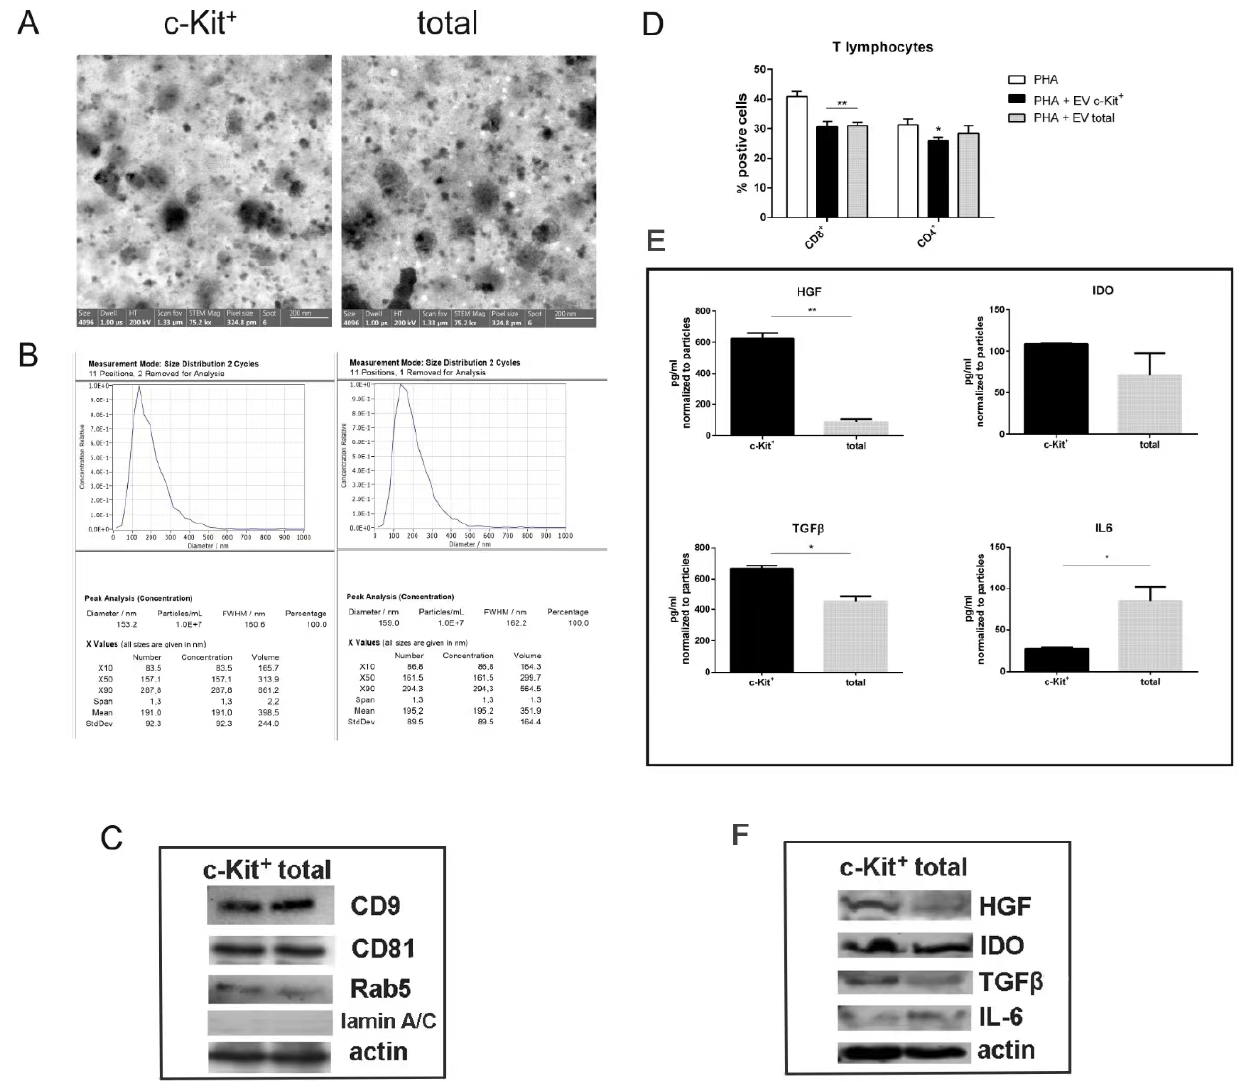
Figure 5. Comparison of the extracellular vesicles produced by amniotic fluid cells selected or not for c-Kit. ( A ) Representative TEM images of negative staining of vesicles obtained from two types of amniotic fluid cells. ( B ) Representative nanoparticle tracking analysis (NTA) performed on EV suspension with ZetaView. ( C ) Representative images of Western blot analysis of EV samples, revealed with anti-CD9, anti-CD81, anti-Rab5, anti-lamin A/C, and anti-actin as a loading control. ( D ) PBMCs, treated with PHA, were exposed for four days to EVs. The graphs show the cytofluorimetric analysis of the percentage of PBMC positive for CD4 and CD8 surface markers. *** p < 0.001; ** p < 0.01 = samples significantly different. ( E ) ELISA analysis of TGF β 1, IDO, HGF, and IL-6 on the two lysates of isolated EVs. ** p < 0.01; * p < 0.05 = samples significantly different. ( F )